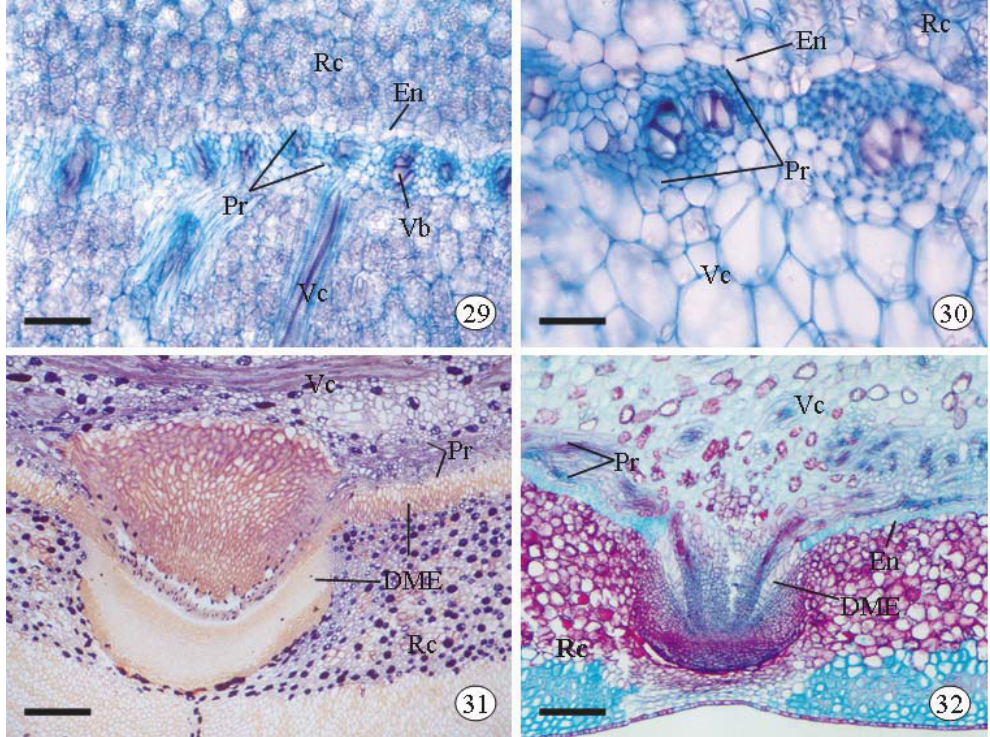
Fig. 29-32 – Transverse sections of the rhizome of Zingiber officinale (Fig. 29 and 30) and longitudinal sections of rhizomes of Lagenocarpus rigidus (Fig. 31) and L. junciformis (Fig. 32). In Zingiber the endodermis (En) has no meristematic activity, the generating layer being the pericycle (Pr). In Lagenocarpus rigidus the rhizome presents DME (Derivatives of the Meristematic Endodermis), whereas in L. junciformis the endodermis does not possess meristematical activity in the rhizome. Rc – rhizome cortex; Vc – vascular cylinder. The bars correspond respectively to: 200 µ m, 50 µ m, 400 µ m and 400 µ